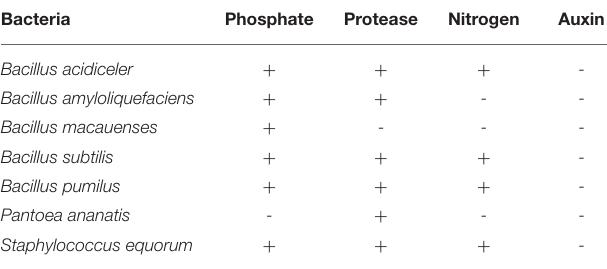
TABLE 2 | Production test of biochemical compounds by bacteria, evaluation of phosphate solubilization, protease production, biological nitrogen fixation, and auxin